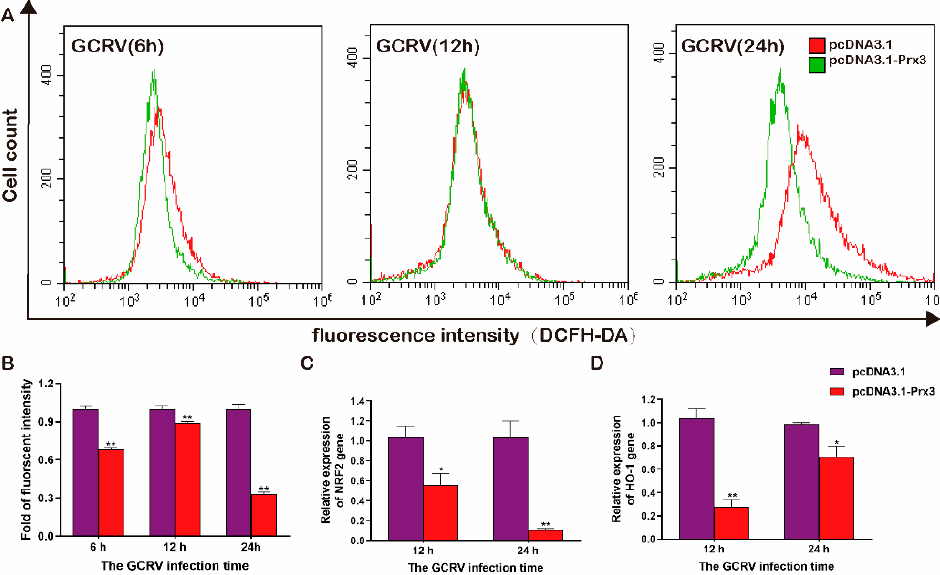
Figure 6. CiPrx3 reduced the ROS caused by GCRV infection. ( A ) Flow cytometry assayed the intracellular ROS caused by GCRV infection. GCO cells were transfected with pcDNA3.1- CiPrx3 or pcDNA3.1 and then infected with GCRV and collected at different time points (6 h, 12 h, and 24 h) to detect the intracellular ROS by flow cytometry. ( B ) The calculated relative fluorescence intensity of GCO cells. ( C , D ) The mRNA expression levels of nuclear factor erythroid 2-related factor 2 (NRF2) and heme oxygenase-1 (HO-1). Data were shown as the mean ± SD ( n = 3). Asterisks represent significant differences (* = p ≤ 0.05, ** = p ≤ 0.01).